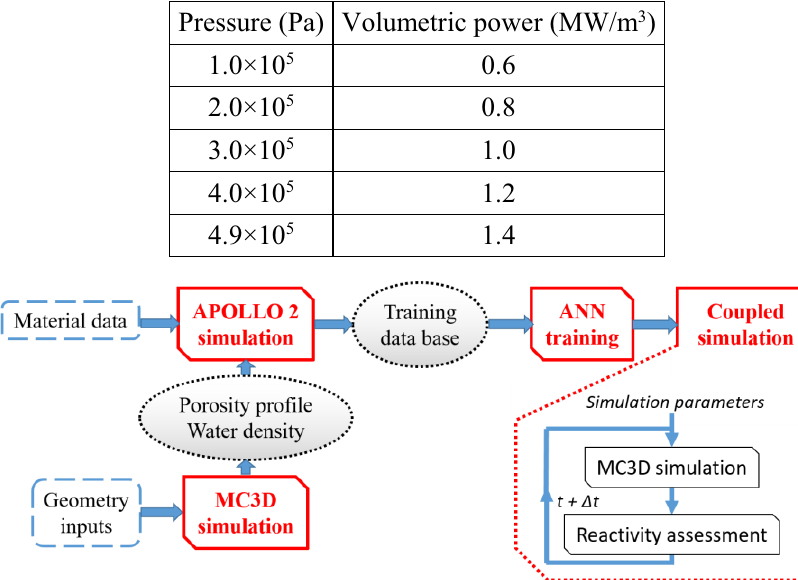
Figure 2: Data exchange